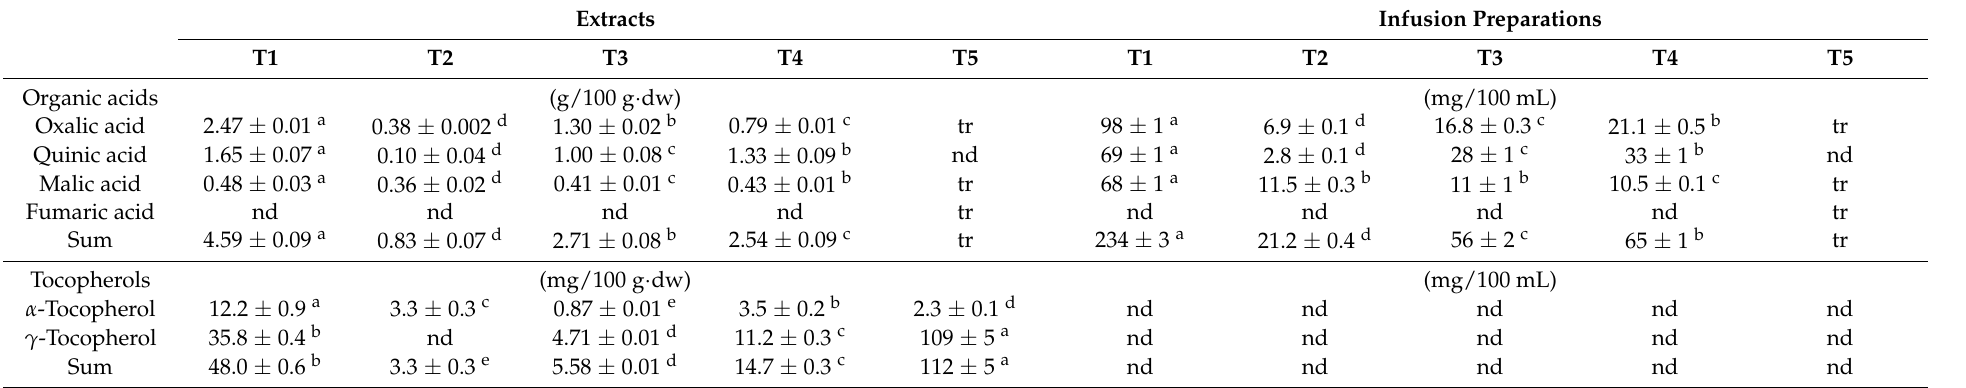
Table 4. Characterization of organic acids and tocopherols in mixtures of dried tisanes (extracts) and infusions preparations (mean ± SD).